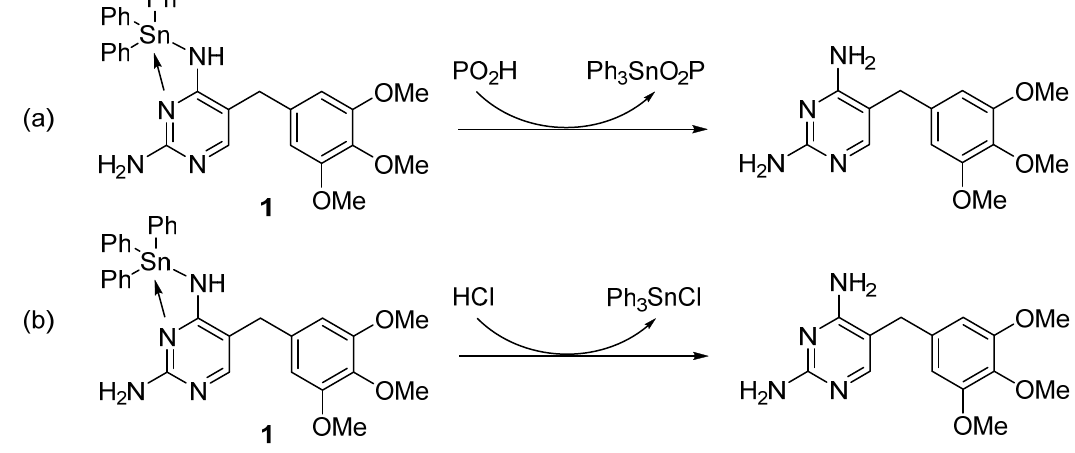
Figure 9. PVC stabilization in the presence of 1 by acting as ( a ) a peroxide decomposer and ( b ) a HCl scavenger.